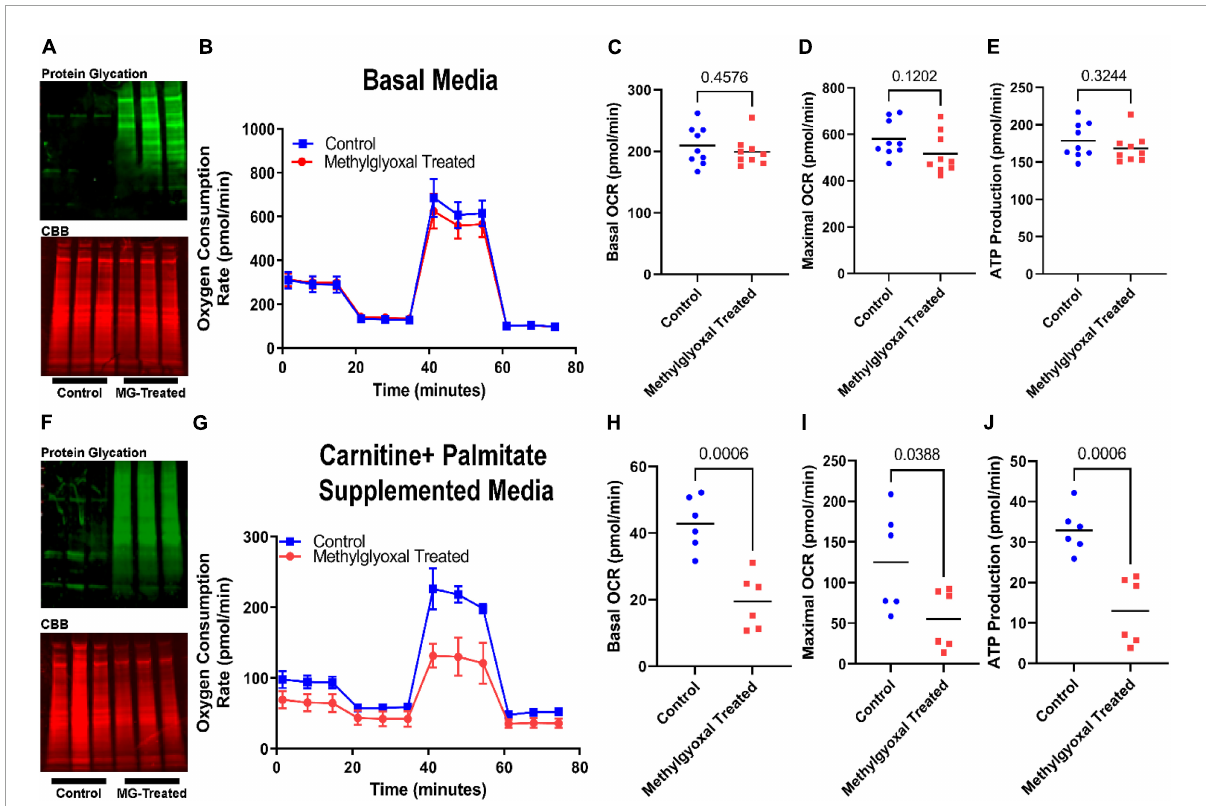
FIGURE2 Exogenous methylglyoxal treatment impaired mitochondrial function when H9c2 cardiomyoblasts were exposed to palmitate. (A) Western blot of total protein glycation (top) and Coomassie brilliant blue (CBB) SDS-PAGE of control and methylglyoxal treated cells subjected to Mito Stress test. (B) Representative Seahorse tracings of cells treated with vehicle or methylglyoxal in the Mito Stress test protocol. Media contained 10 mM glucose, 1 mM pyruvate, and 2 mM glutamine. Quantification of basal oxygen consumption rate (C) , maximal oxygen consumption rate (D) , and ATP production (E) . (F) Western blot of total protein glycation (top) and CBB SDS-PAGE (bottom) of control and methylglyoxal treated cells undergoing fatty acid oxidation assay. Media included basal media supplemented with 0.5 mM carnitine and 169 µ M palmitate. (G) Representative Seahorse tracings of cells treated with vehicle or methylglyoxal in the fatty acid oxidation protocol. Quantification of basal oxygen consumption rate (H) , maximal oxygen consumption rate (I) , and ATP production (J) . P -values determined by unpaired t